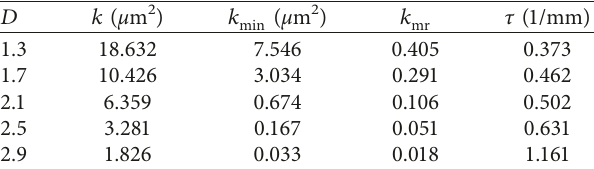
Table 5: Barree–Conway seepage model parameters of fractured sandstones in different fractal dimensions.